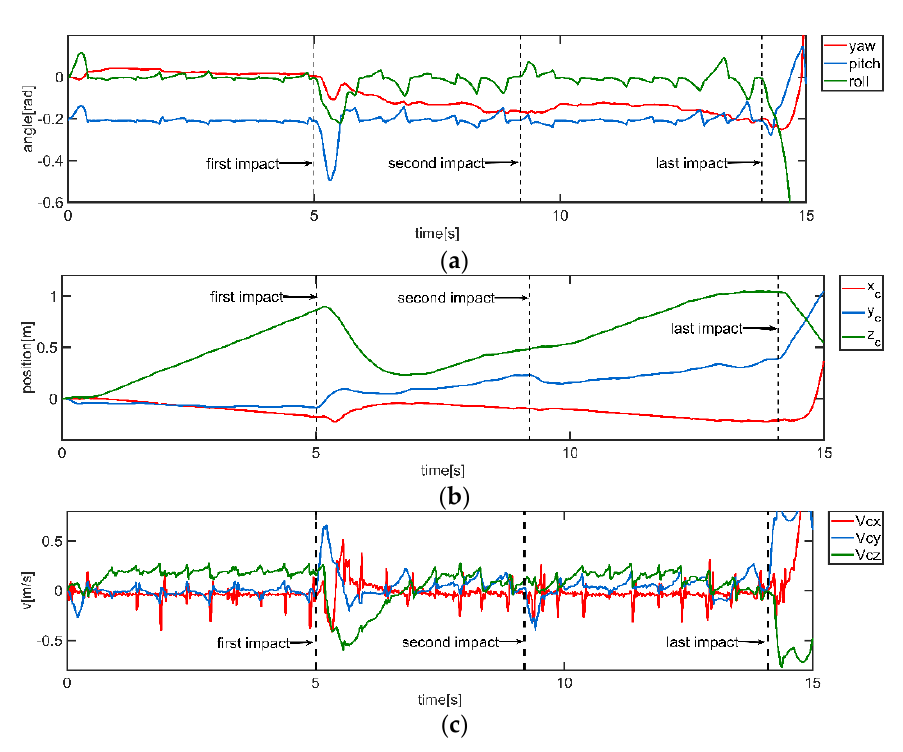
Figure 31. Sensor data of the motion with impact in Simulation 3: ( a ) posture angles of the principal-axes coordinate system; ( b ) positions; and ( c ) velocities of the body.